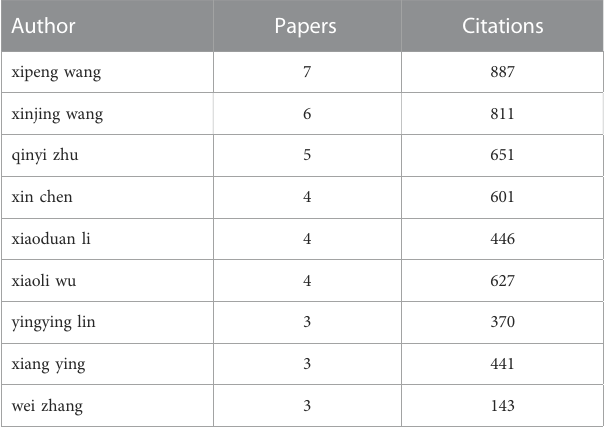
TABLE 2 Most productive authors in terms of number of publications in the fi eld of exosome and EOC. Author Papers